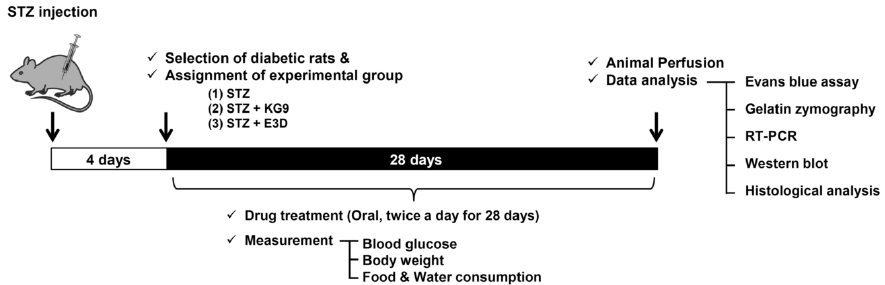
Figure 1. Scheme of experimental design.